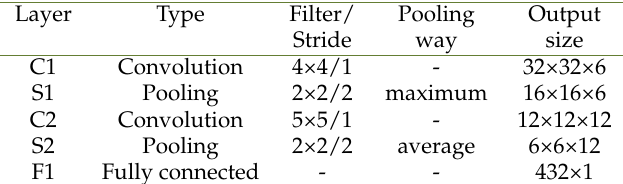
Fig. 5. Time-frequency energy image of seven fault sig- nals of AG fault in Line 1 Table 1. Relevant parameters of